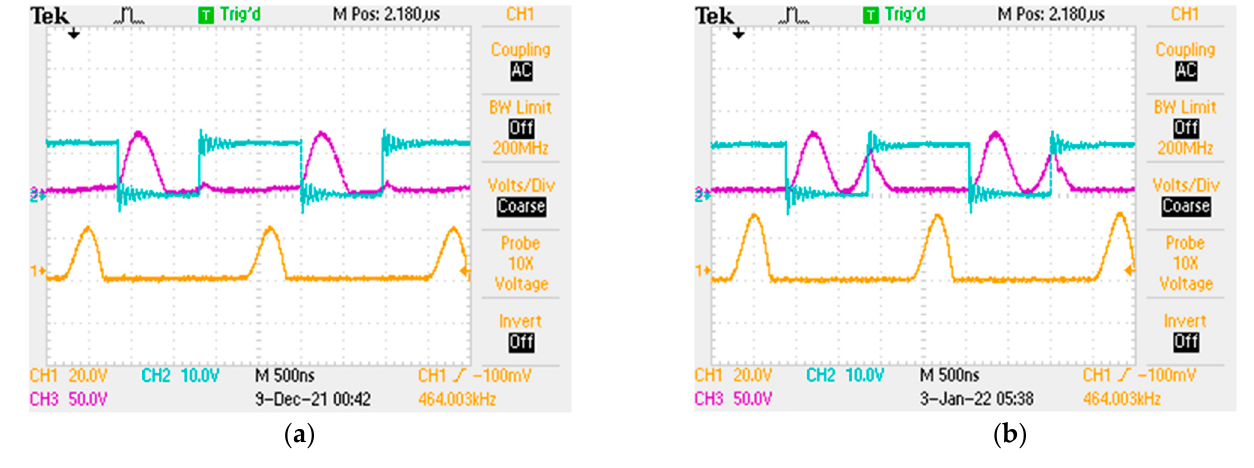
Figure 9. Waveform of the class-E 2 with 8-plate multi-resonant coupling (blue: gate signal, purple: voltage across MOSFET, orange: voltage across diode) ( a ) without misalignment and ( b ) with 10% misalignment.